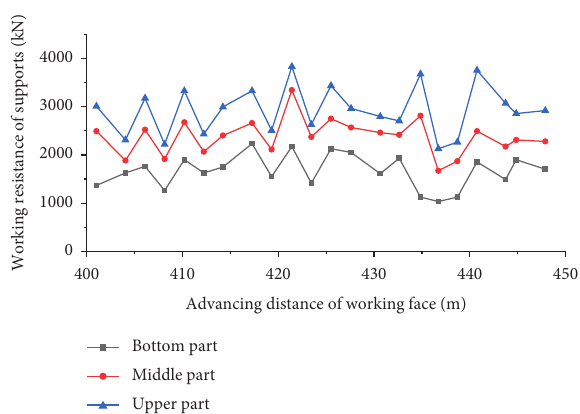
Figure 21: Monitoring results of the support work resistance in the working